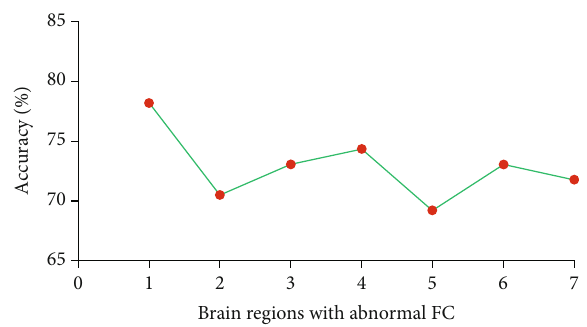
Figure 2: Accuracy (%) of abnormal FC values in a single brain region to discriminate OCD from HCs. FC: functional connectivity; OCD: obsessive-compulsive disorder; HCs: healthy controls; 1: bilateral medial prefrontal cortex; 2: bilateral lingual gyrus; 3: left superior parietal lobule; 4: bilateral precuneus; 5: bilateral orbitofrontal cortex; 6: left orbitofrontal cortex; 7: right